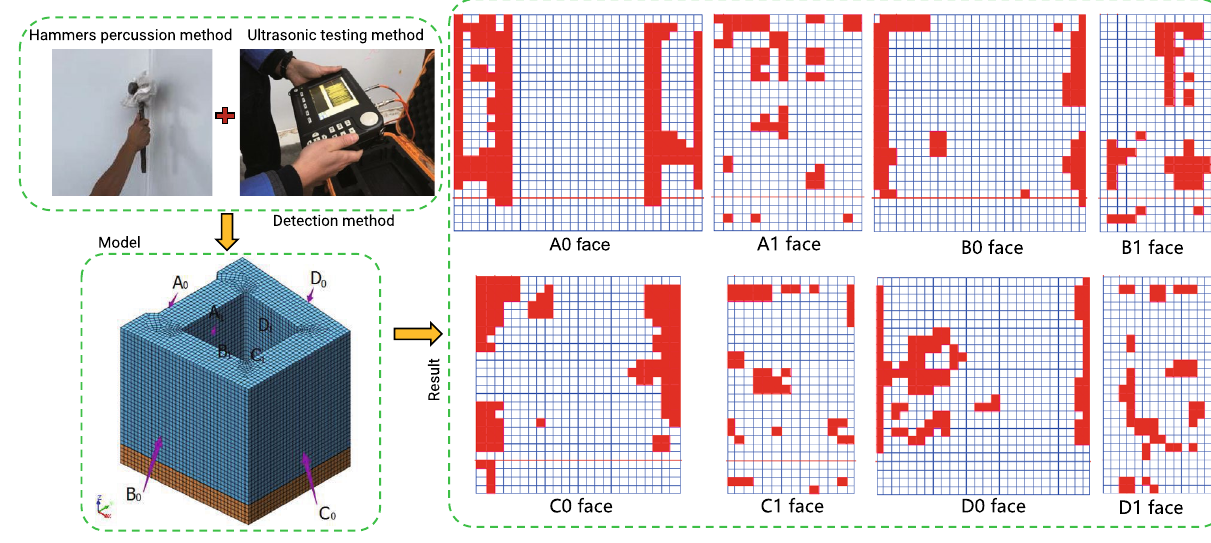
Figure 14. Detection results of concrete hollowing.